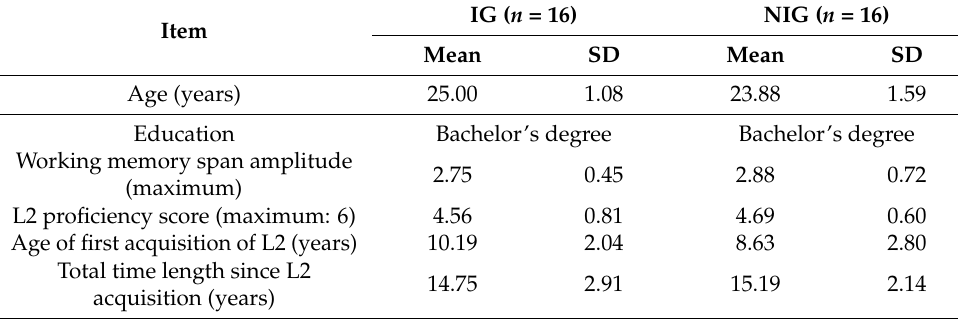
Table 1. Characteristics of the study groups.